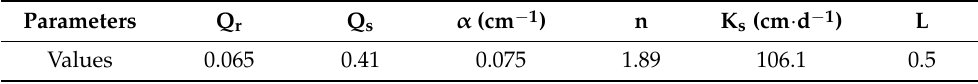
Table 4. The hydraulic parameters of sandy loam soil.